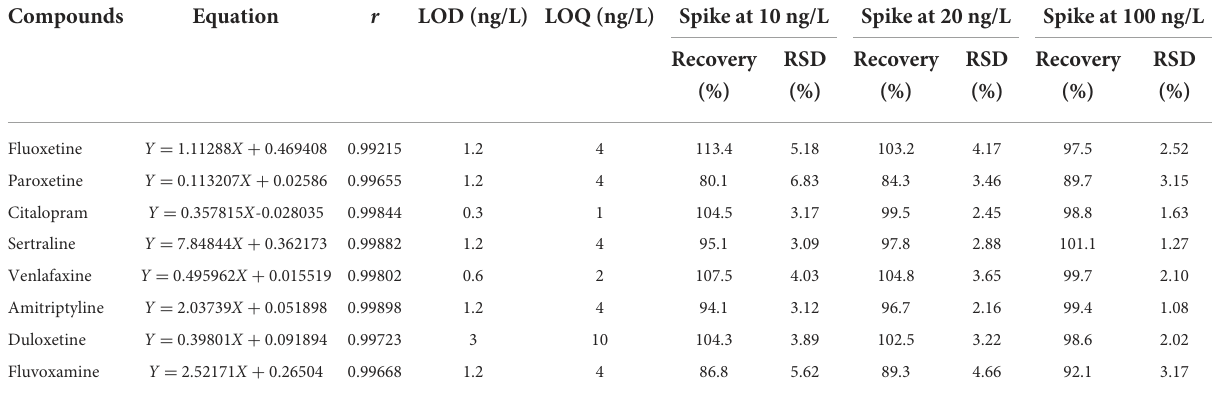
TABLE 2 Regression equation, coefficient, limit of detect (LOD), limit of quantification (LOQ), recovery and relative standard deviation (RSD) of eight antidepressant drugs ( n = 3).